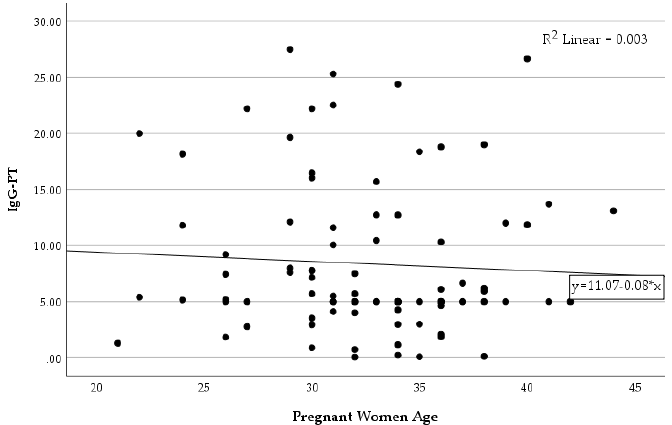
Figure 5. Regression PW age-IgG-PT levels (in patients with a non-protective level of antibodies).